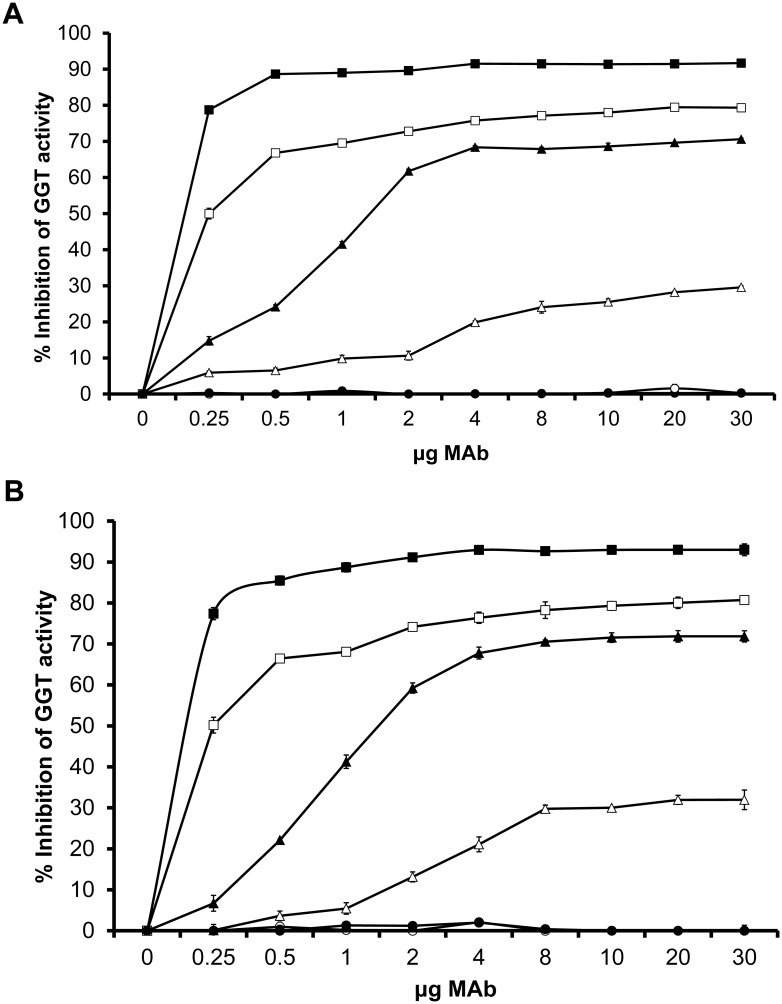
Neutralizing ability of GGT MAbs on rGGT and H. pylori 88–3887 GGT activity.(A) rGGT (5mU) or (B) a population of 5 × 106
H. pylori WT was pre-incubated with various amounts of MAb 1G1 (■), 4F11 (□), 3F4 (▲) or 3C10 (Δ) (0 to 30μg of IgG protein) for 1 hour at 37°C on microtitre plates. Mouse IgG2a (●) and IgG2b (○) isotype controls were used in parallel at the same concentrations. Inhibition of GGT activity by MAbs was measured using GGT assay and values represent GGT activity inhibition (expressed as a percentage) compared to the control where no MAb was added. Experiments were performed in triplicates and values represent the means ± SD from 3 independent experiments.